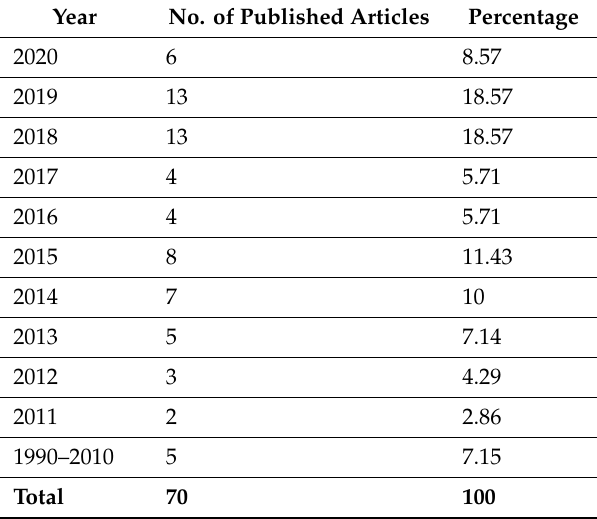
Table 2. Total number of published articles, by year.